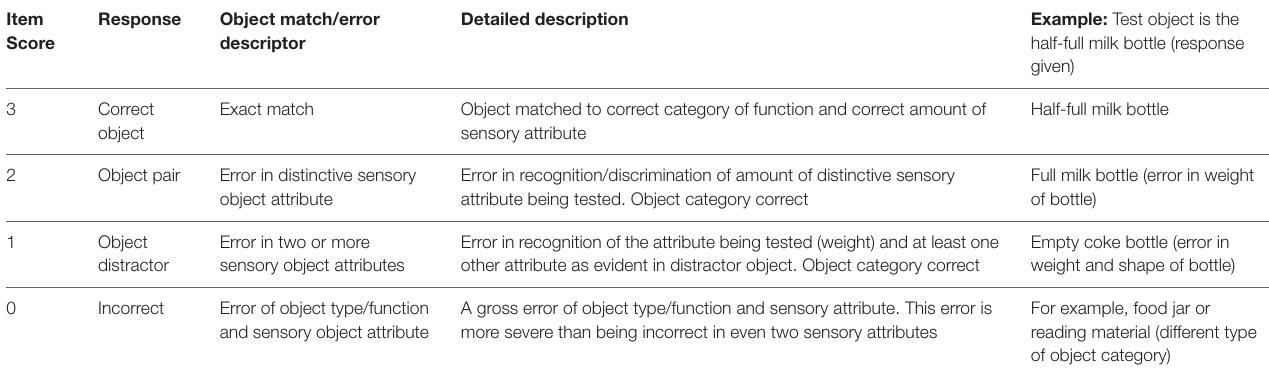
TABLE 2 | Item response scoring according to the object and sensory attribute descriptors, with